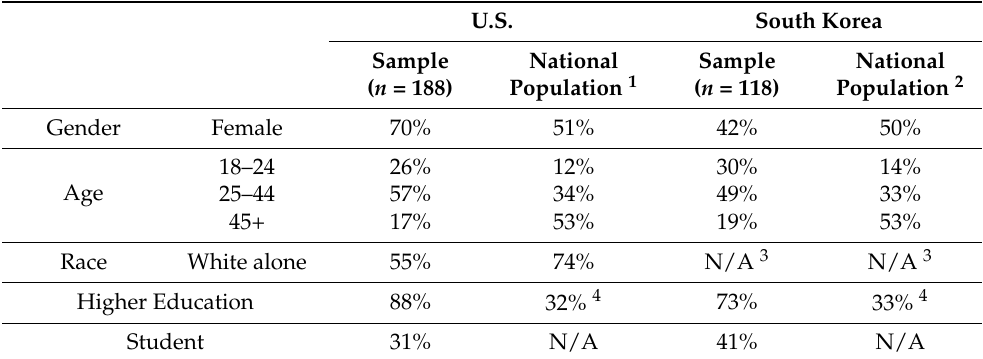
Table 1. Sociodemographic characteristics of the U.S. ( n = 188) and South Korea ( n = 118) survey participants, and comparison with those of the national populations.